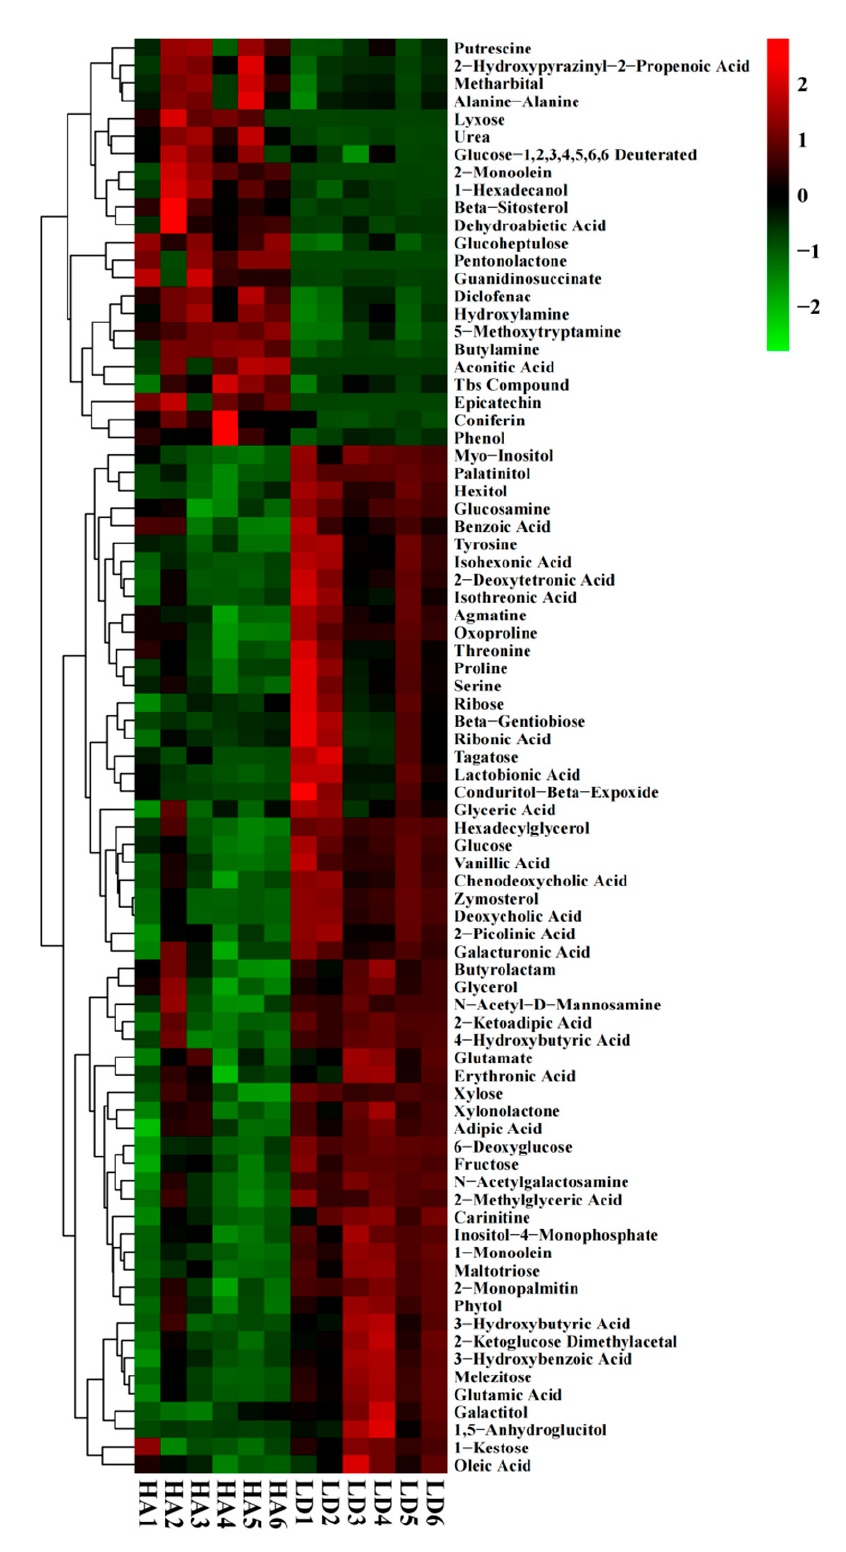
Figure 6. Thermogram analysis of different metabolites in bayberry rhizosphere soil. LD1-6 and HA1-6 represent the absence and presence of humic acid in diseased bayberry trees, respectively.